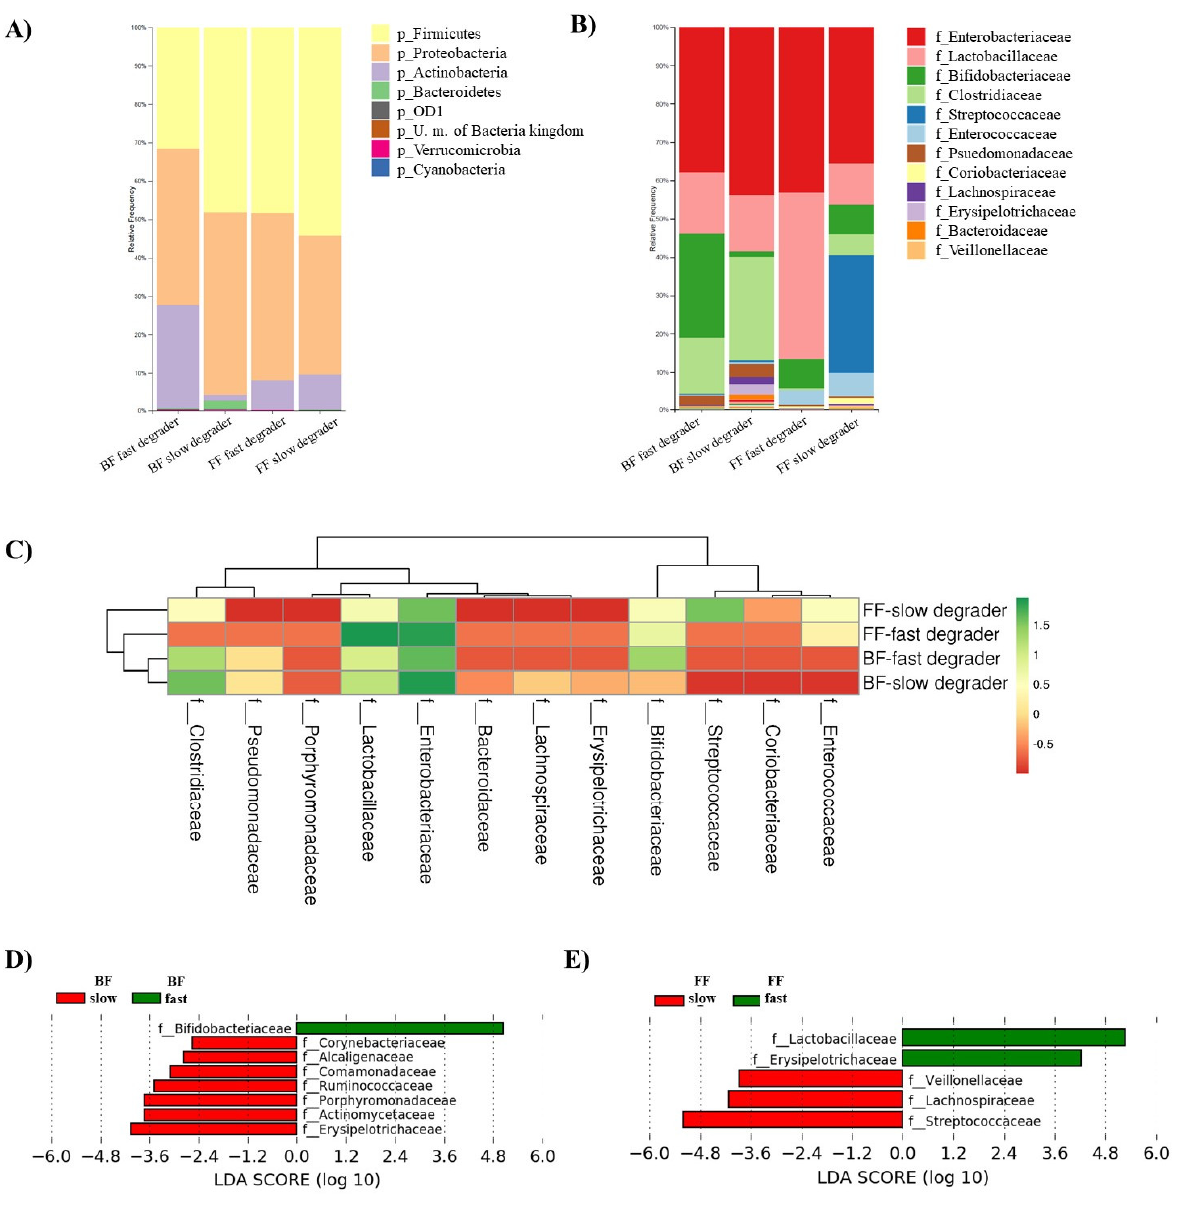
Figure 3. Characteristics of the microbiota from fecal cultures after 24 h of incubation in the presence of 2 (cid:48) FL in the four groups considered according to feeding type and 2 (cid:48) FL degradation rate: BF-fast degraders, BF-slow degrader, FF-fast degrader, FF-slow degraders. Relative abundance of bacteria at Phylum ( A ) and Family levels ( B ). Heatmap of the log-transformed relative abundances of microbial taxa at the family level, which display differences in microbial profiles among the four culture groups (combination of BF/FF and Fast/Slow 2 (cid:48) FL degraders) ( C ). Linear Discriminant Analysis (LDA) scores of microbial taxa at family level that were differentially altered in cultures of fast (green) and slow (red) degrades, according to the feeding type of fecal donors: breastfed ( D ) or formula-fed ( E ).